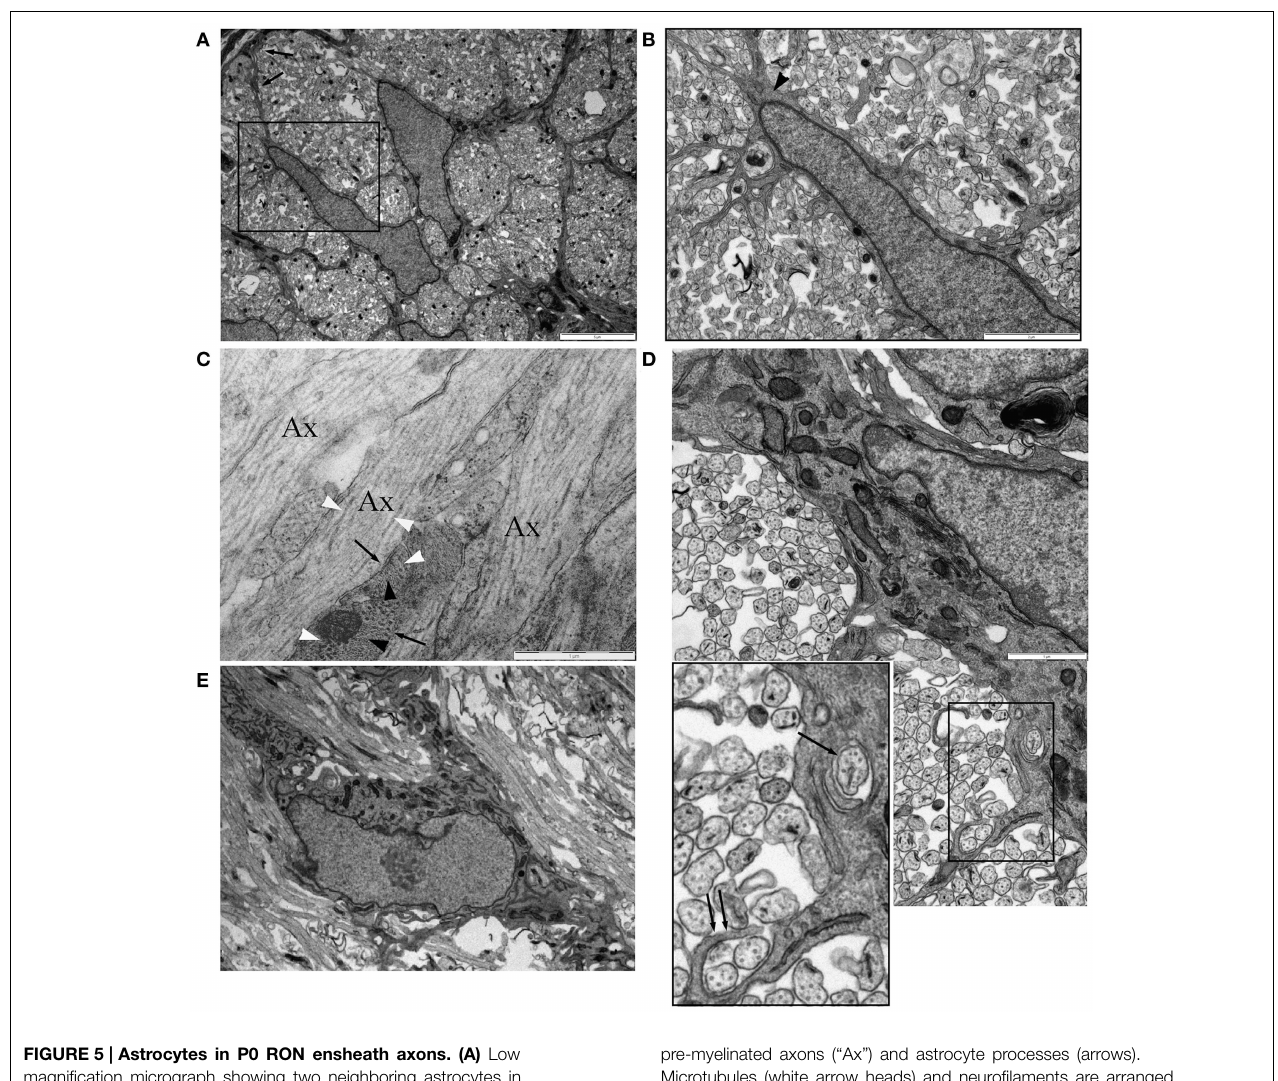
pre-myelinated axons (“Ax”) and astrocyte processes (arrows). Microtubules (white arrow heads) and neurofilaments are arranged longitudinally in axons while glial filaments (black arrow heads) are arranged generally transversely in astrocyte processes. (D) Montage showing an astrocyte ensheathing a single axon (arrow) and extending a finger process around two axons (double arrow). Boxed area shown at higher gain in the inset. (E) An astrocyte shown in long-section extending thick processes parallel to pre-myelinated axons.